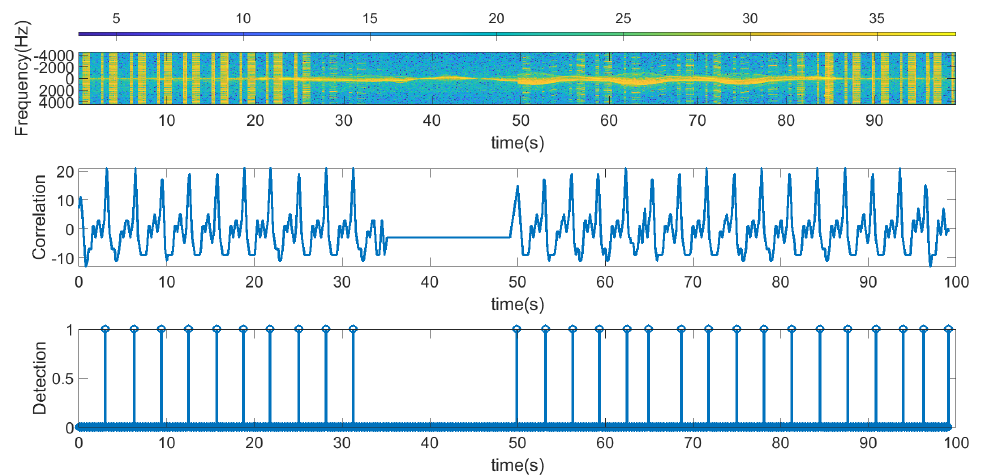
Figure 26. Data measurement using length 7 Barker codes when the scooter is in motion. From top to bottom: raw spectrogram before CFAR processor is applied, the output of the correlator signal and tag detection. In this case, the tag is partially out of range.